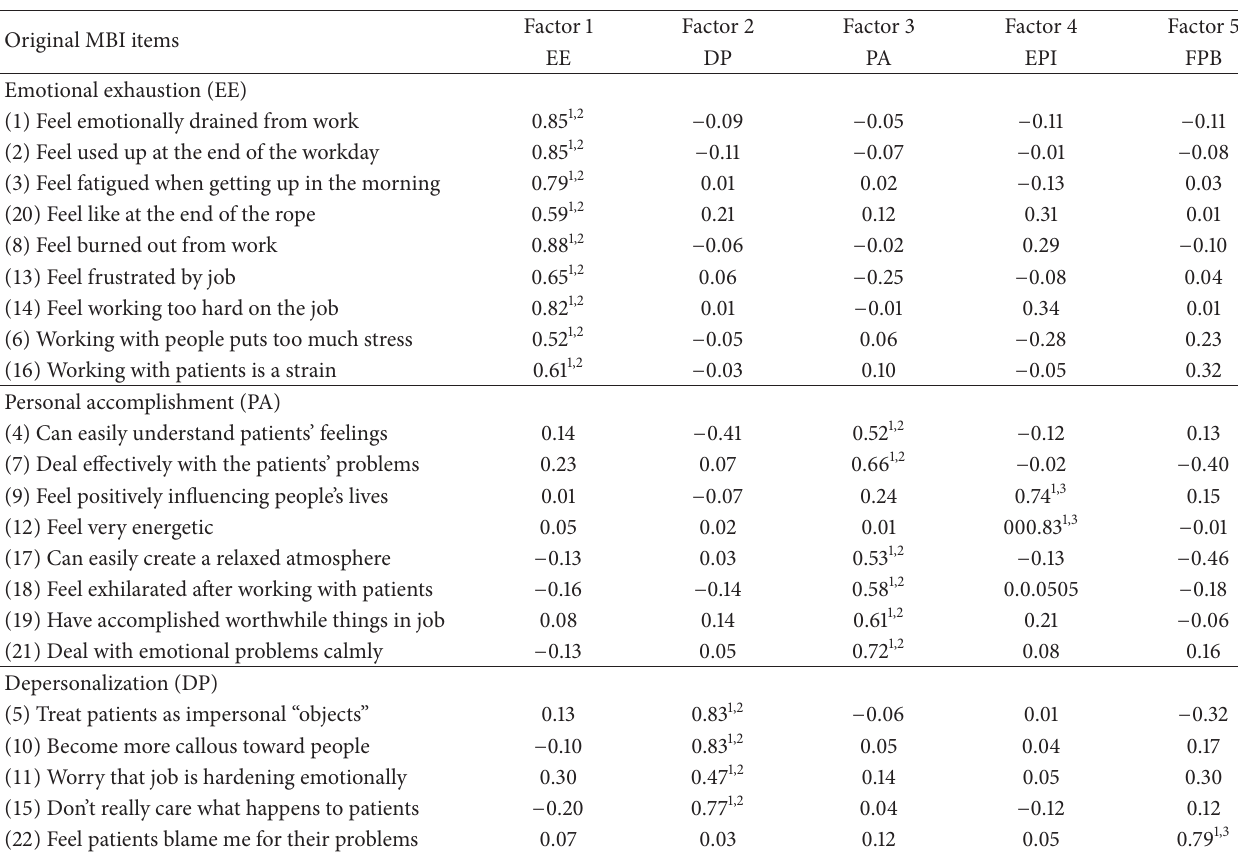
Table 3: Exploratory factor analysis of the Serbian version of the